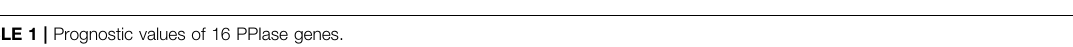
TABLE 1 | Prognostic values of 16 PPIase genes.